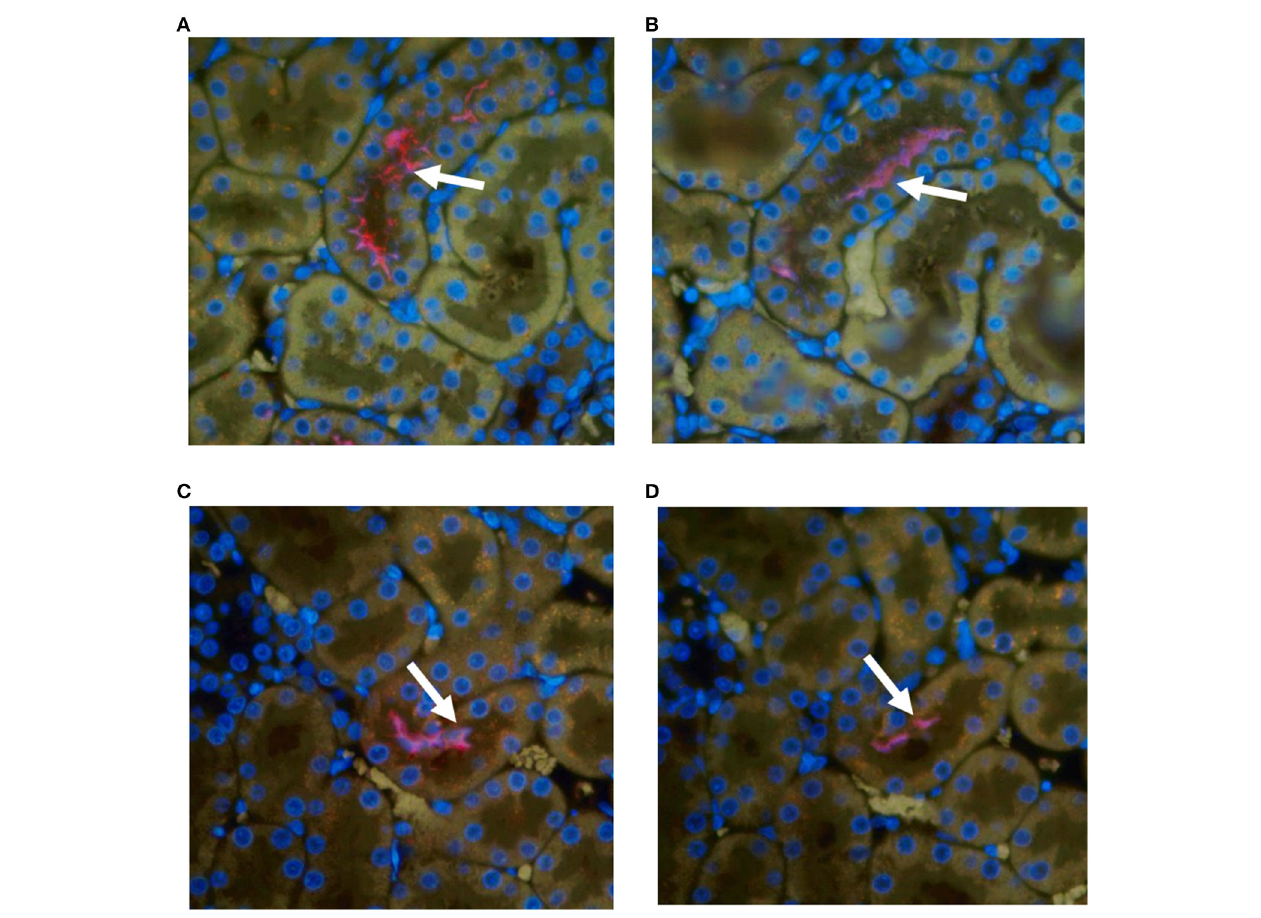
FIGURE 1 | Representative immunohistochemical staining of kidneys from experimentally infected rats at 8 weeks post-infection with anti-OMV (A,C) or anti-LipL32 (B,D) . Arrows indicate positive renal tubules. Original magnification × 400.